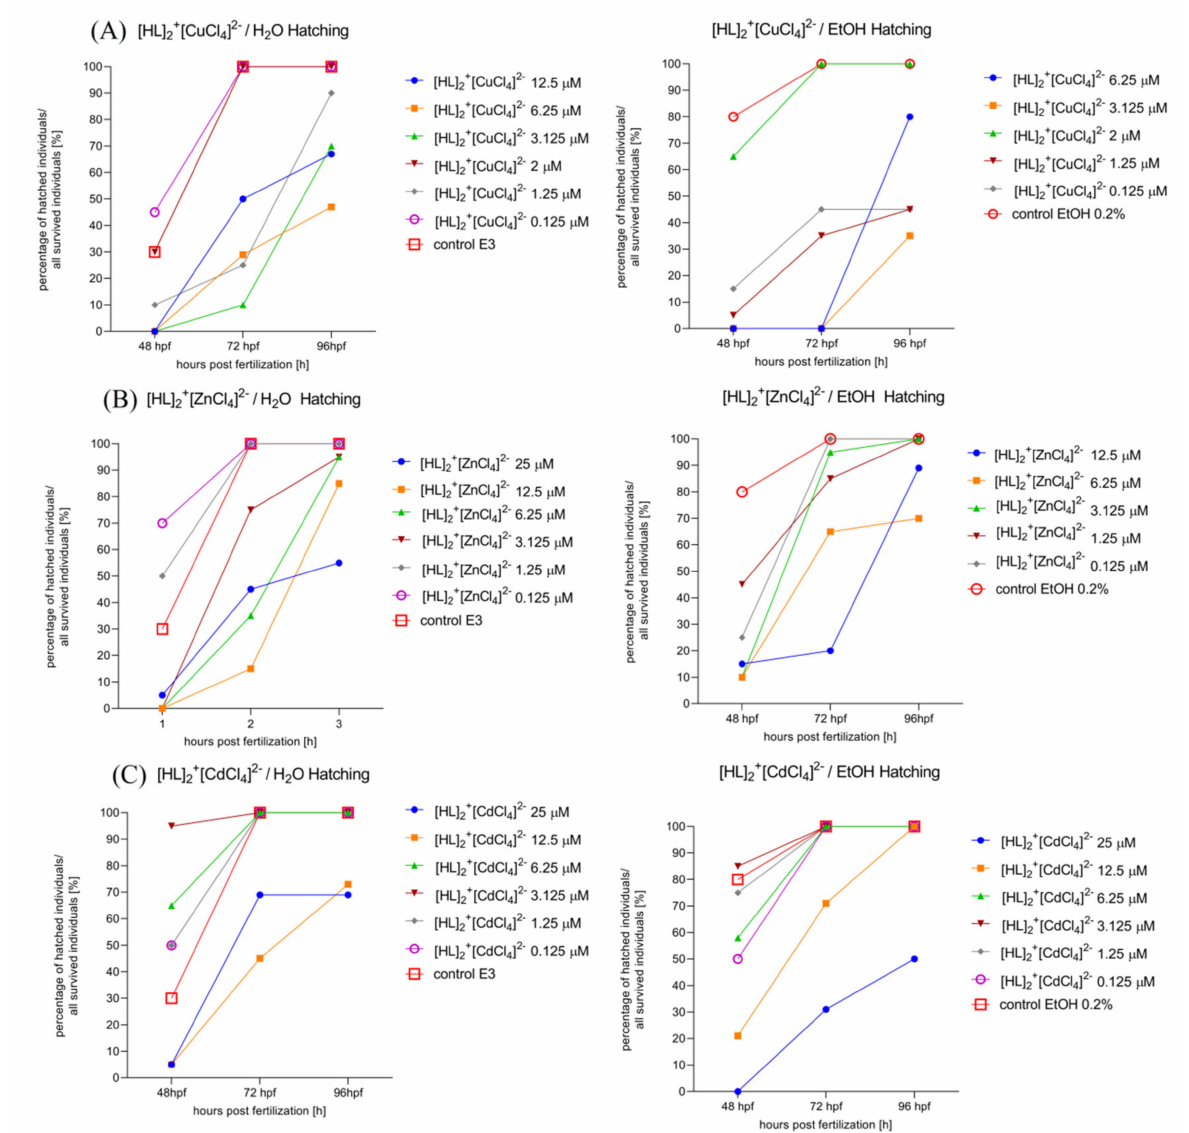
Figure 9. Solvent-dependent effect (ethanol ( left )/water ( right )) effect of [HL] 2+ [CuCl 4 ] 2 − ( A ), [HL] 2+ [ZnCl 4 ] 2 − ( B ), and [HL] 2+ [CdCl 4 ] 2 − ( C ) on the hatching rate after 48 hpf, 72 hpf, and 96 hpf of Zebrafish